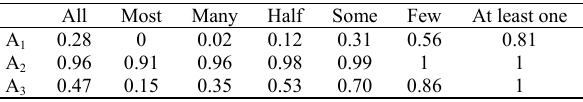
Table 13. The overall relative closenesses under different decision attitudes.